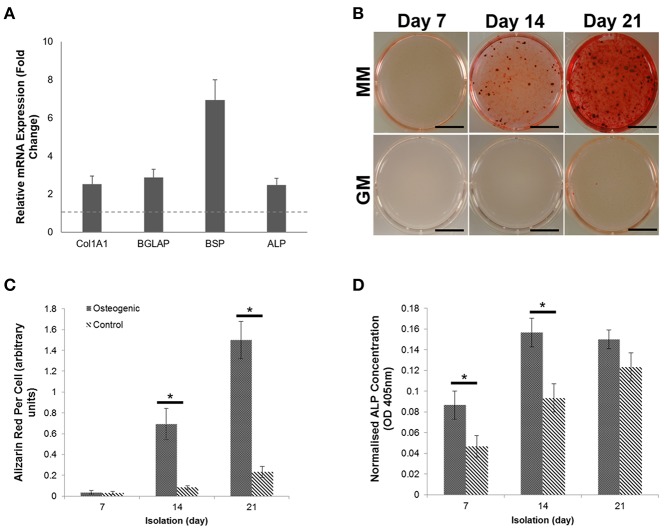
Characterization and differentiation of human primary osteoblasts derived from three separate donors toward a mineralizing phenotype over a period of 21 days. (A) Gene expression profiling of primary human osteoblasts showed upregulation of four osteogenic markers. (B) Differentiation of osteoblasts cultures in the presence of growth medium (GM) and mineralization medium (MM) containing 10 nM β-glycerophosphate and 50 μg/mL L-ascorbic acid over a period of 7, 14, and 21 days induced extracellular matrix mineralization, which was visualized using Alizarin red calcium stain. (C) Visual differences in mineralization observed using Alizarin red were confirmed semi-quantitatively. (D) The concentration of Alkaline phosphatase (ALP) was calculated per cell. Significant increases in ALP concentration were observed at days 7 and 14. Scale bars = 15 mm, *p ≤ 0.05. N = 3.